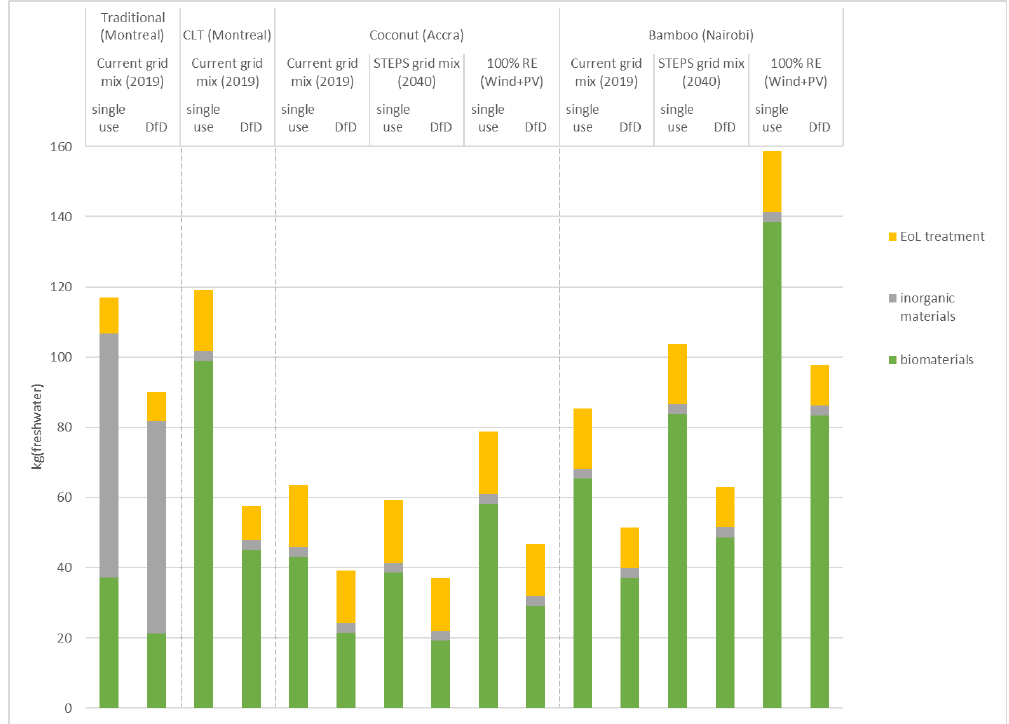
Figure 9. Freshwater consumption results for the three wall assemblies and locations, with sensitivity analyses (FU = 1 m 2 ).